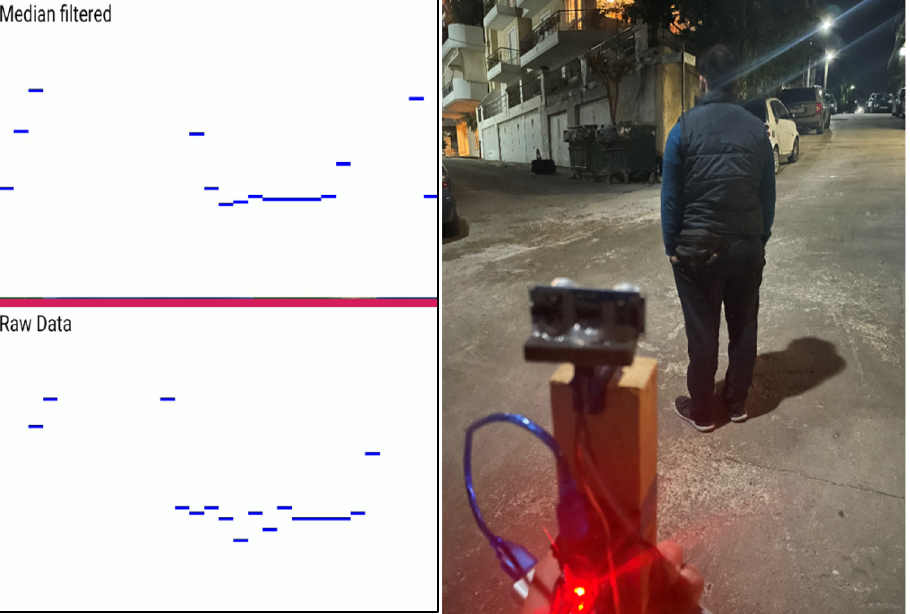
Figure 25. Response of sonar obstacle detection system.